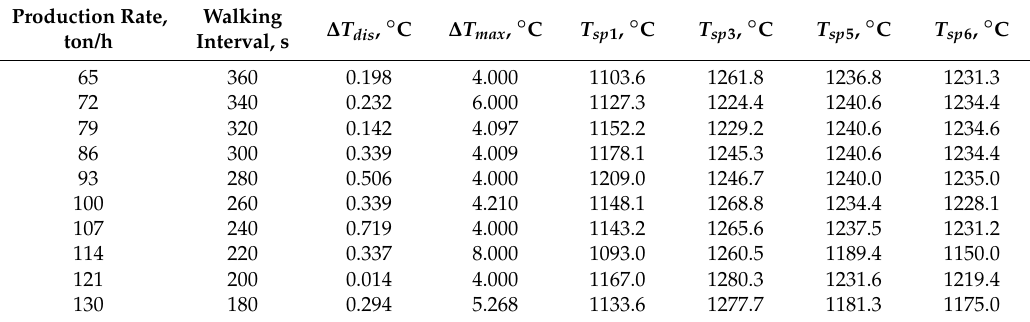
Heating performance and optimal furnace set-point temperatures of different optimisation